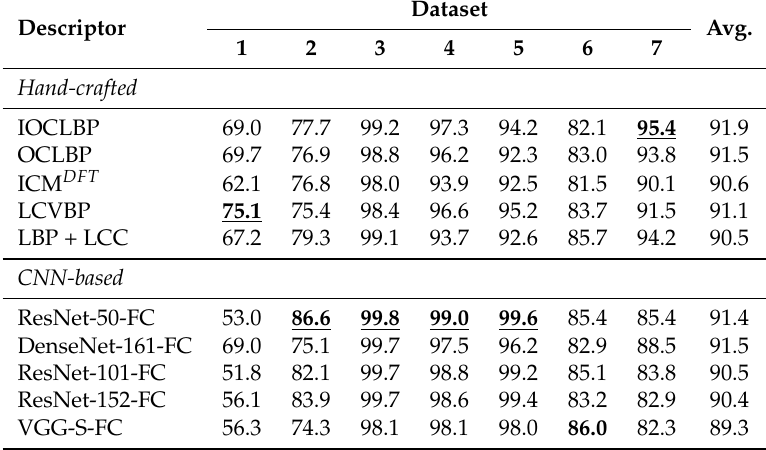
Table 7. Results of Experiment #1 (Part 2: Datasets 8–14): stationary textures acquired under steady imaging conditions. Figures report overall accuracy by dataset. Boldface denotes the highest value; underline signals a statistically-significant difference between the best hand-crafted and the